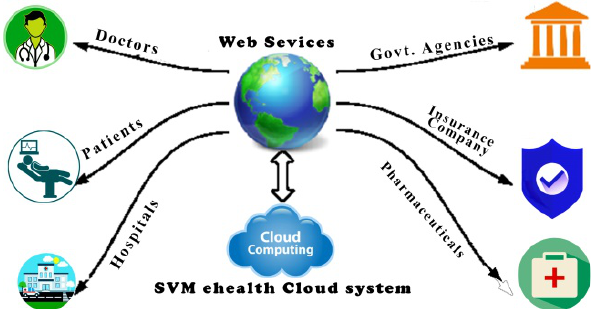
Figure 7. SVM eHealth Cloud System